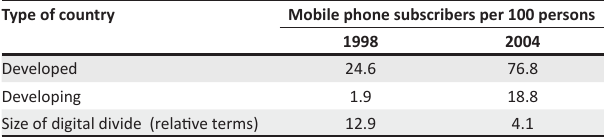
TABLE 2: Digital Divide from